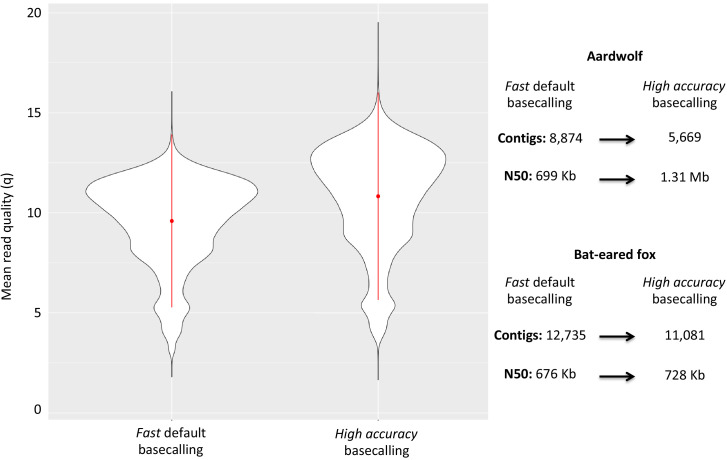
Plot of the quality of Nanopore long reads base-called with either the fast or the high accuracy option of Guppy v3.1.5.The quality of the base-calling step has a large impact on the final quality of the assemblies by reducing the number of contigs and increasing the N50 value.